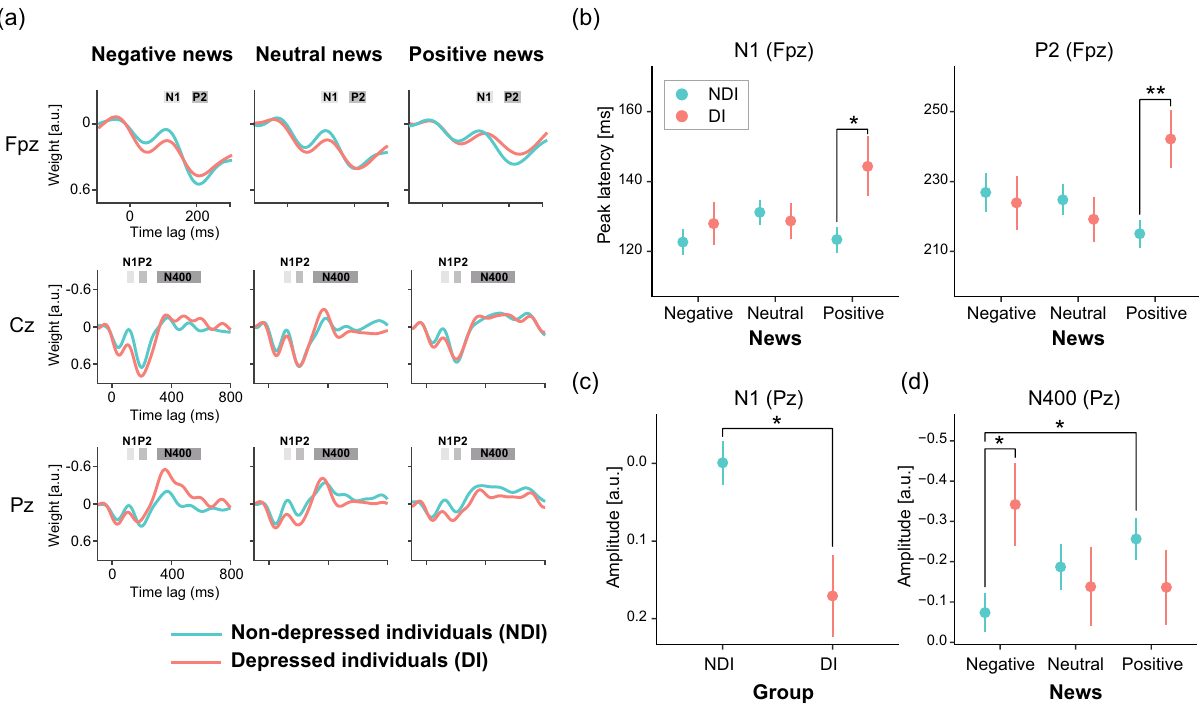
Figure 3. Differences in EEG between groups and between news contents. ( a ) The grand-averaged TRF waveforms in the depressed (pink) and non-depressed individuals (cyan) by channel and news are shown. The highlighted time windows were used to calculate the mean amplitudes of the components corresponding to N1, P2, and N400, respectively. ( b ) The depressed individuals had longer peak latencies of N1 and P2 at Fpz for the positive news than the non-depressed individuals. ( c ) The non-depressed individuals showed more negative deflection than the depressed individuals did in the N1 amplitude at Pz. ( d ) The depressed individuals showed more negative deflection in the N400 amplitude at Pz than the non-depressed individuals did while listening to the negative news. In addition, the negative news caused smaller negative deflection than the positive news, only in the non-depressed individuals. Each circle and error bar of ( b )–( d ) represent the mean and standard error, respectively. The depressed and non-depressed individuals are colored in pink and cyan, respectively. * p < 0.05 and ** p <